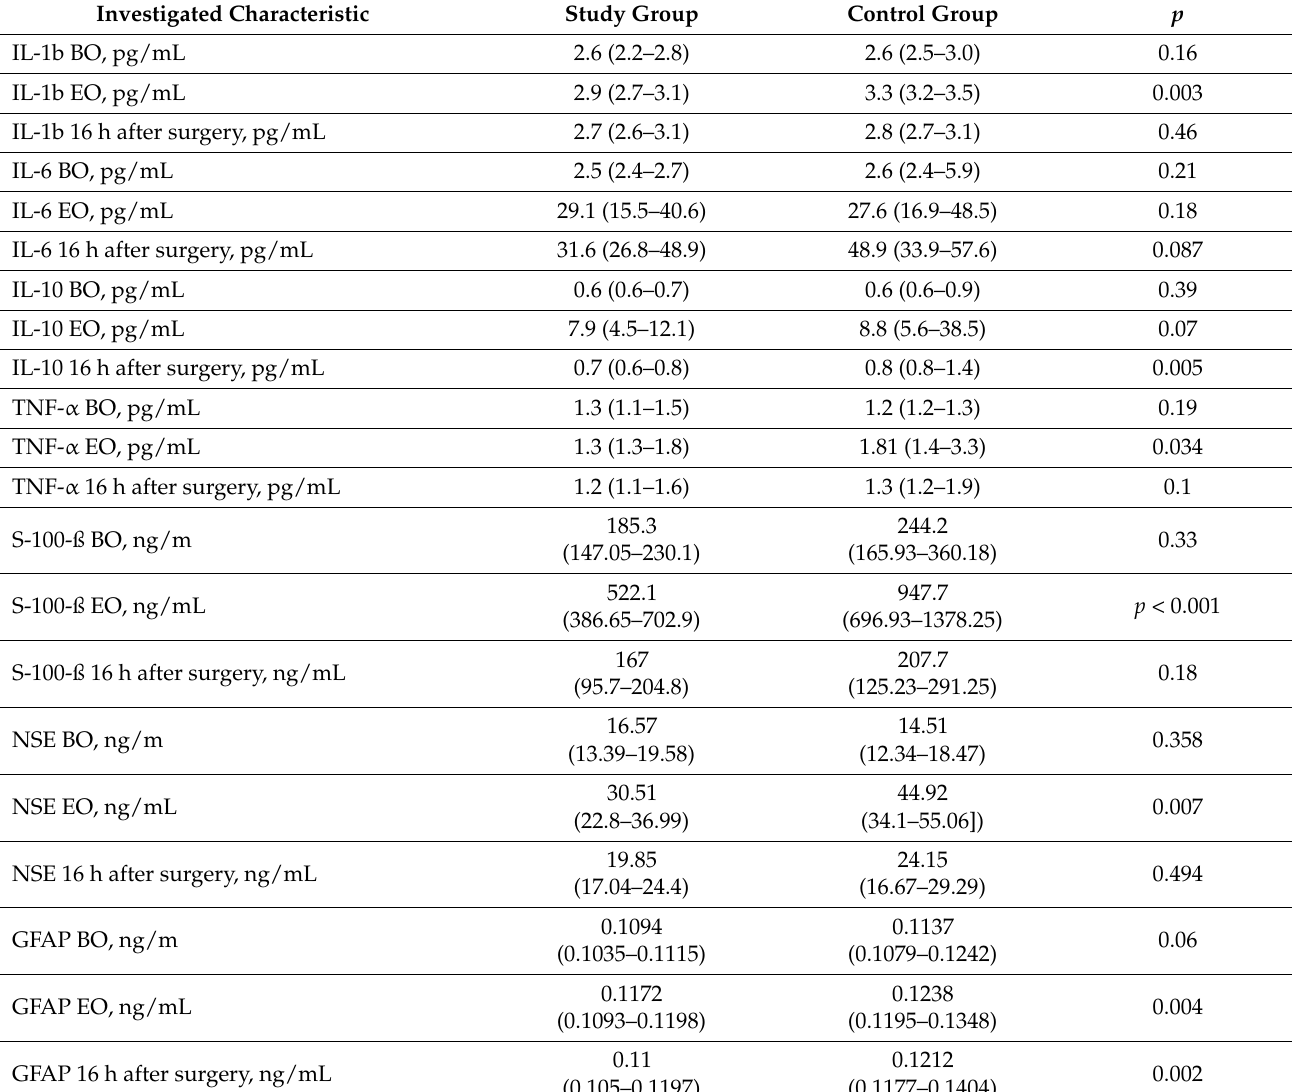
Table 4. Dynamics of